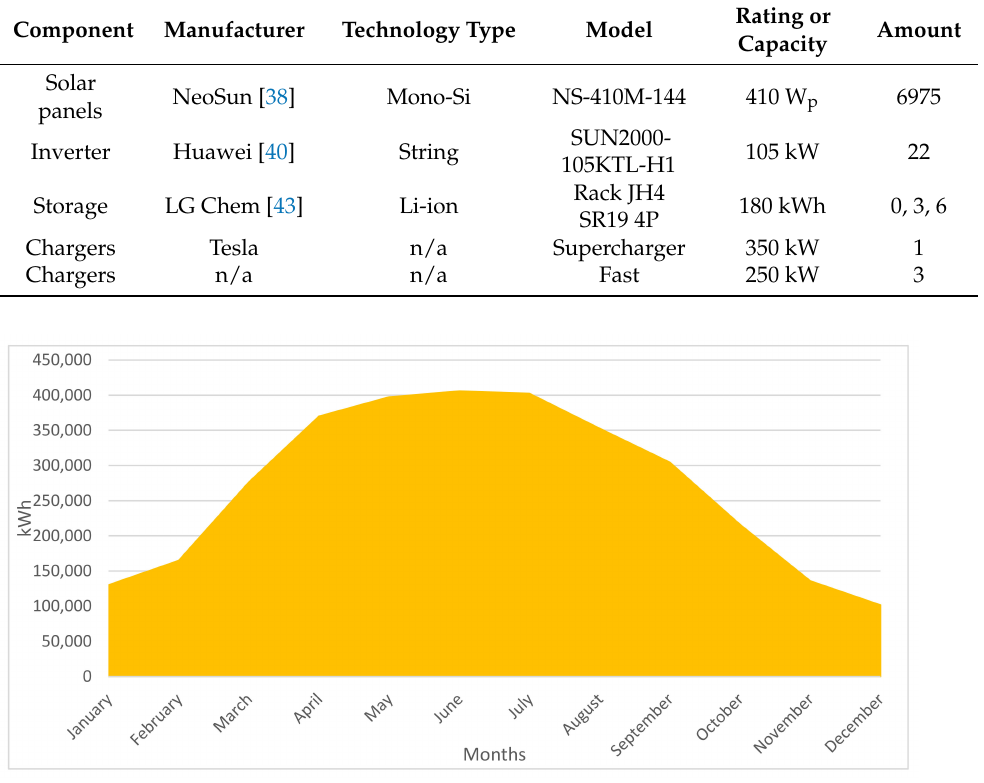
Figure 3. Monthly PV power production per year of a 2.8-MW system in Blindley Heath, Surrey,